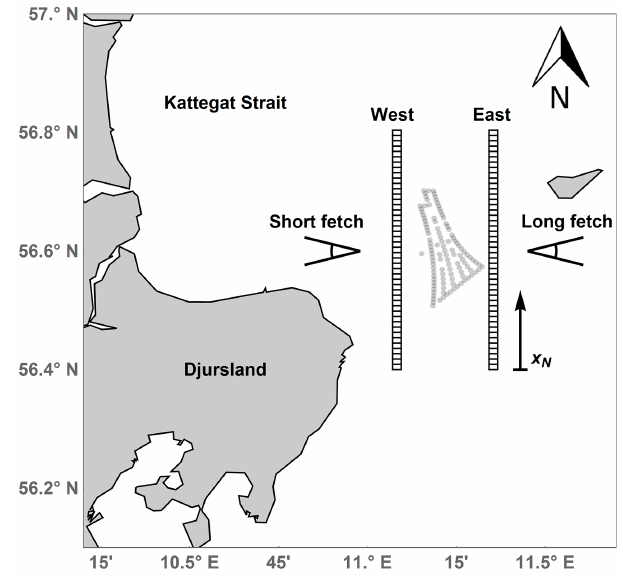
Figure 7. Location of the Anholt wind farm and investigated tran- sects. Two transects “West” and “East” are following the north– south